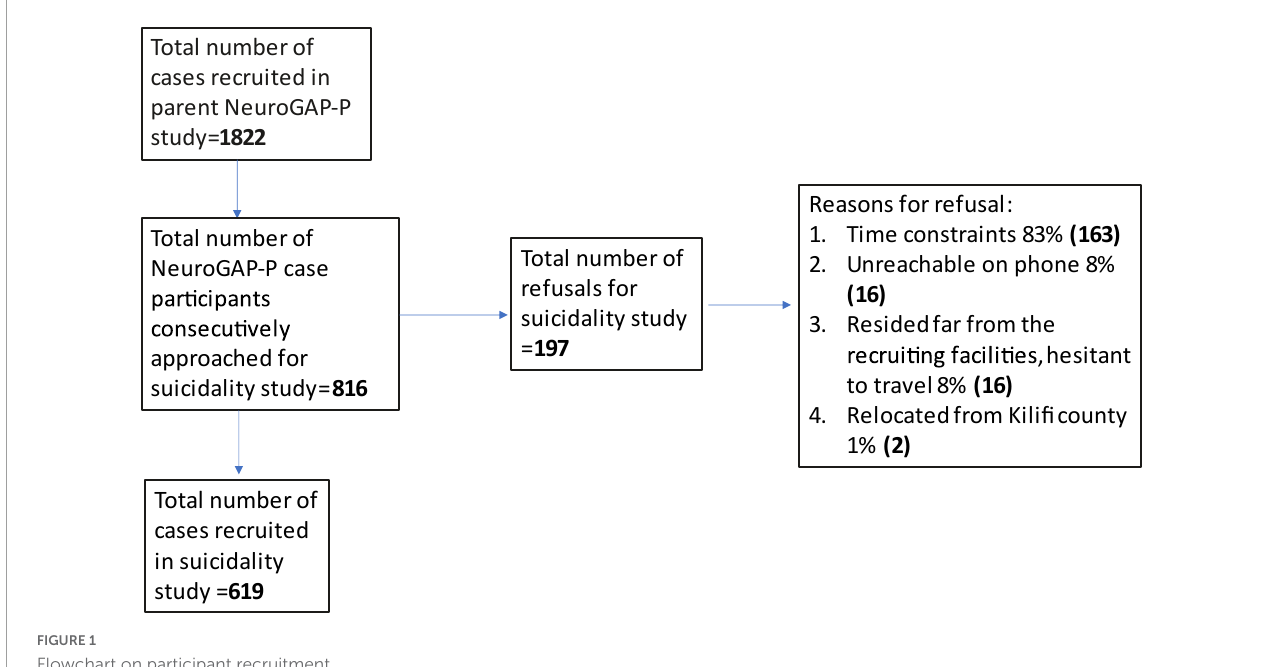
FIGURE1 Flowchart on participant